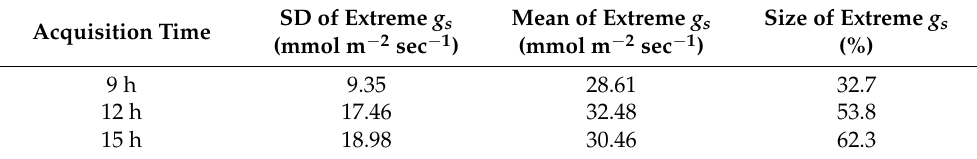
Table 3. Statistics of the extreme gs over all irrigation regimes at three times of the day. Acquisition